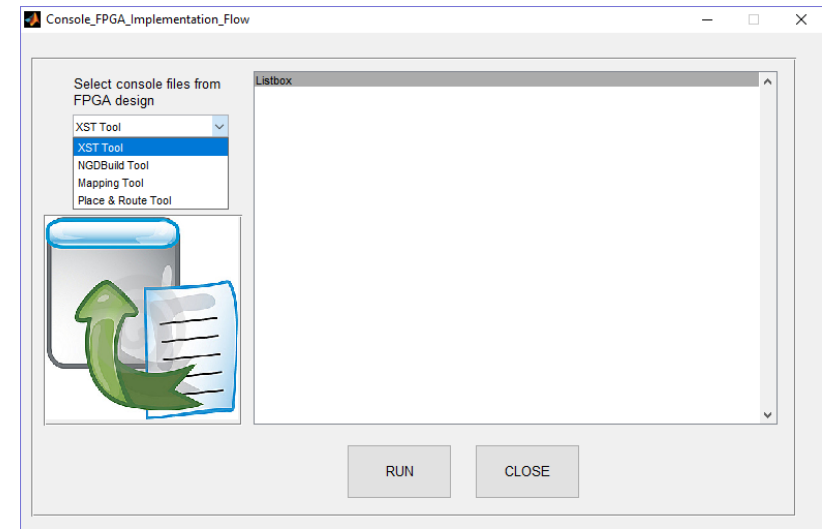
Figure 8. Console window reports option in the software design